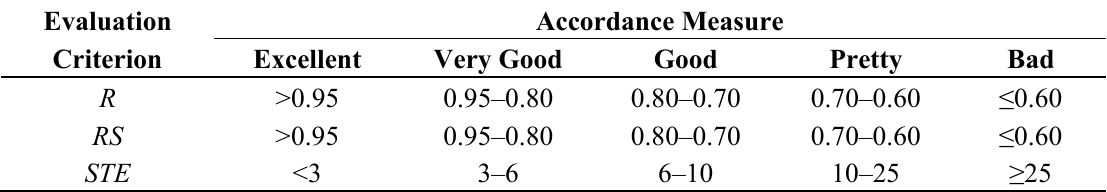
Table 1. Criteria of model quality.